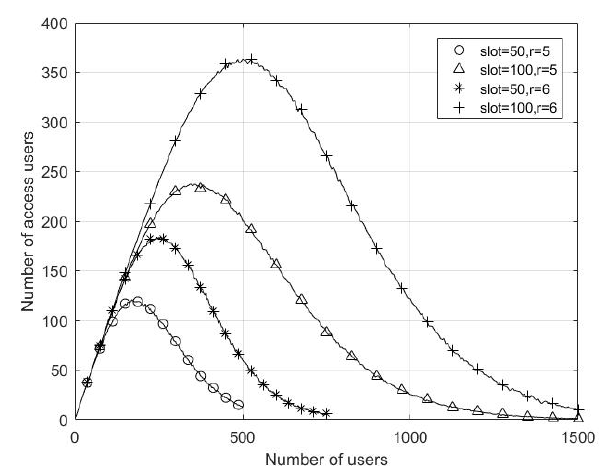
Figure 11. Throughput performance curve of Walsh code time slot random access protocol with different parameters.